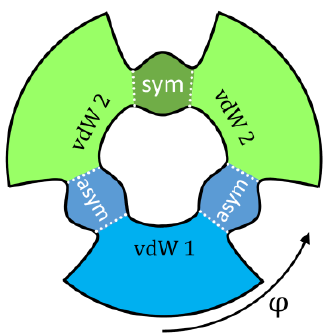
Figure 4. Four areas on the PES of ozone that correspond to the covalent wells with symmetric (green) and asymmetric (blue) ozone molecules, and two types of van der Waals complexes (light blue and light green). Hyper-angle φ is used to differentiate between symmetric and asymmetric ozone molecules. Dotted lines are drawn through transition state regions seen as “bottlenecks” in this figure. This diagram can be compared to both frames of Figure 1.